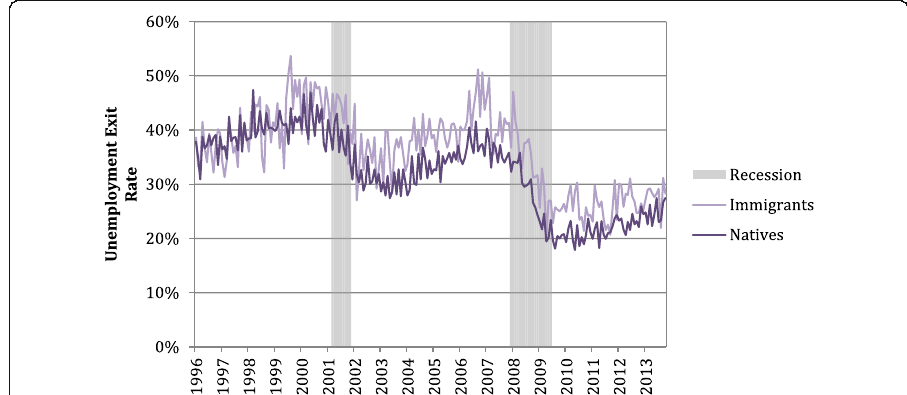
Fig. 3 Seasonally adjusted monthly unemployment exit rates: matched CPS data, 1996 – 2013. Notes: Monthly unemployment exit rates are calculated by author using the matched CPS data. All data are seasonally adjusted. The sample consists of people aged 20 – 64 who are in the labor force for any two consecutive months. Shaded area represents recessions as reported by the National Bureau of Economic Research